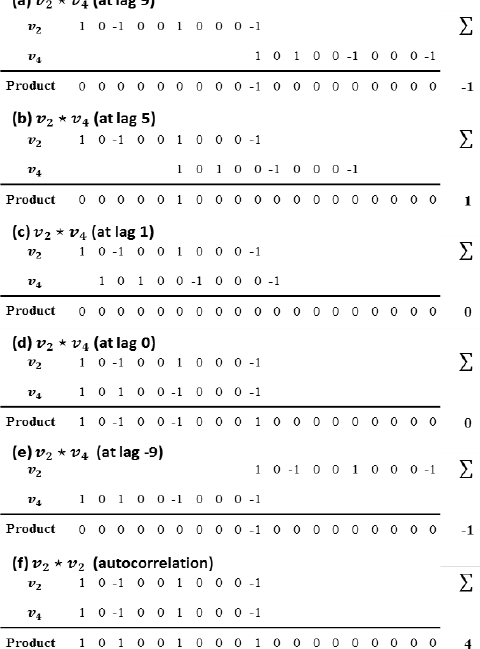
Figure 1. Cross-correlation of v 2 and v 4 at ( a ) lag 9, ( b ) lag 5, ( c ) lag 1, ( d ) lag 0, ( e ) lag − 9, and ( f ) autocorrelation of v 2 .